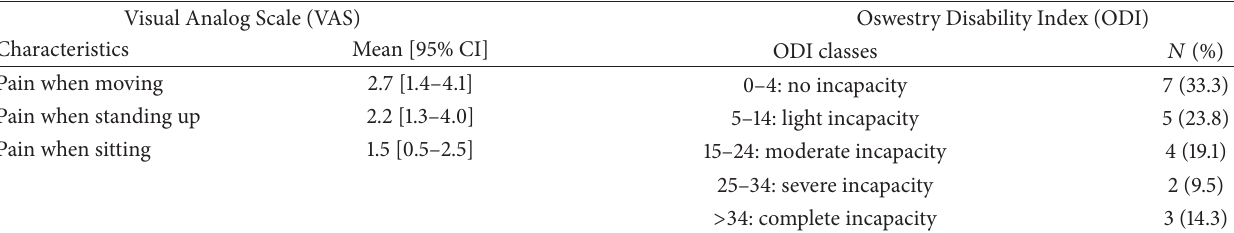
Table 1: Results of quality of life, evaluated using VAS and ODI.